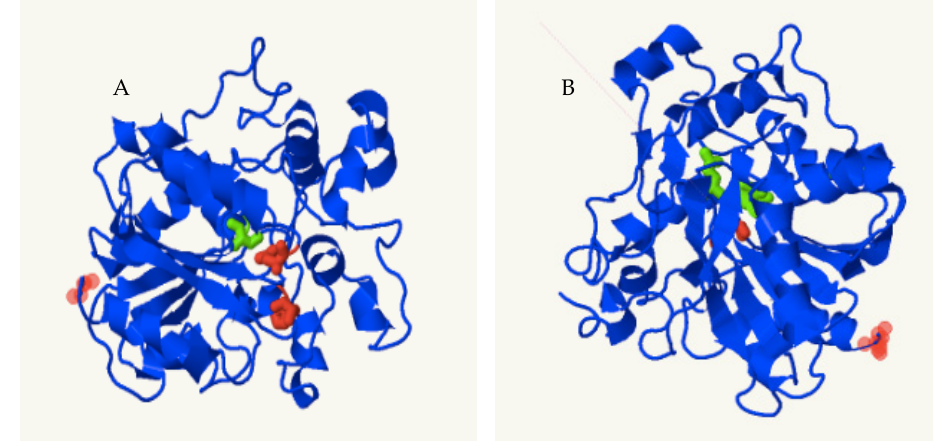
Figure 11. Comparison of predicted 3D structures of proteins encoded by ( A ) P. putida LS46 PhaC1 ls and ( B ) PhaC1 16 . 3D models were constructed with PhaC1 of P. putida LS46 (EMR48251), PhaC1 16 (ALV86417.1) using online Phyre2. Red areas indicate amino acid at putative catalytic sites in the PhaC1 proteins which identical to template. The green area indicates amino acids at the catalytic site, which are different from the template (gastric lipase).